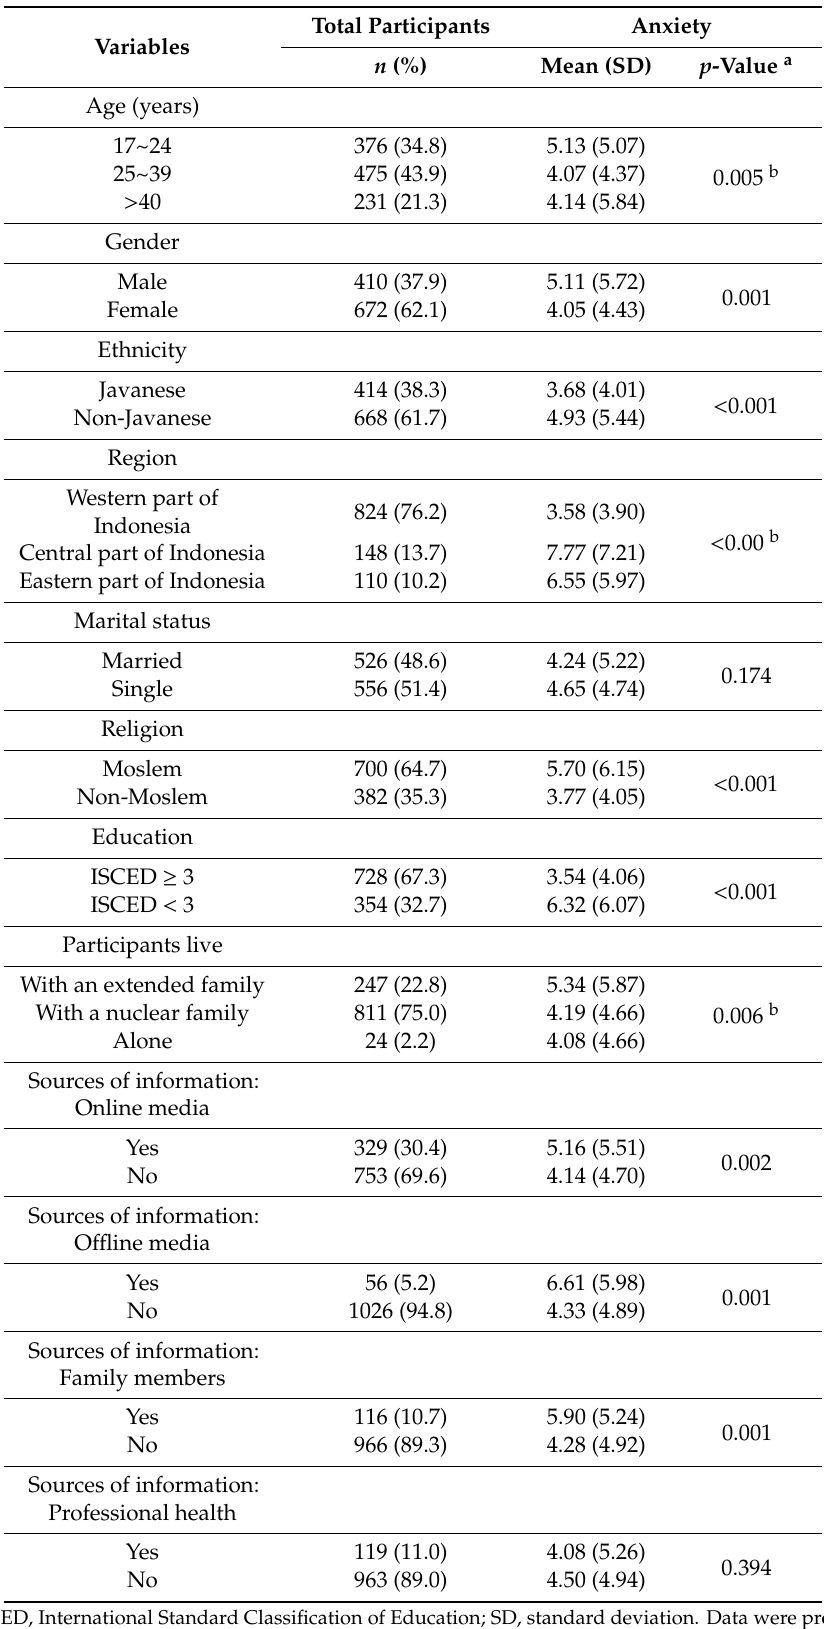
Table 1. Comparisons of participants’ sociodemographic characteristics and anxiety towards the corona virus disease 2019 (COVID-19) pandemic in an Indonesian population ( n =